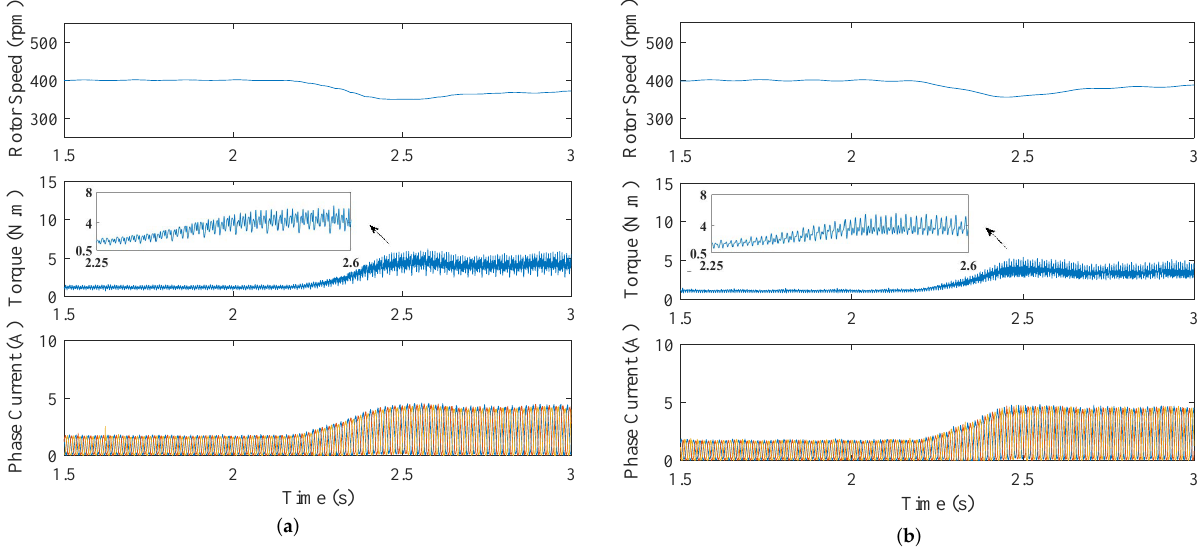
Figure 9. Experimental results of the rotor speed, total torque and phase current with the load torque change. ( a ) Method in [14]. ( b ) 2DOF IMC ADO